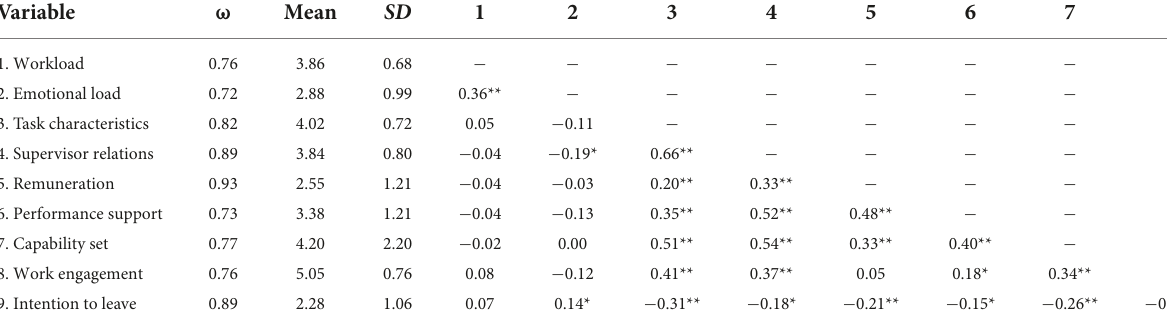
TABLE 3 Descriptive statistics, reliabilities, and correlations of the scales. Variable